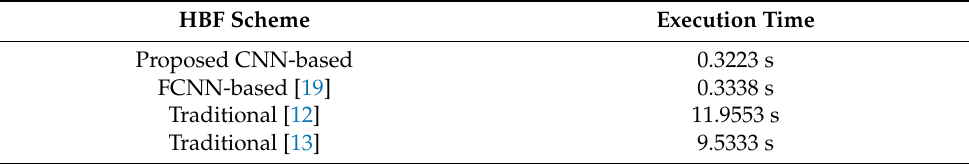
Table 3. Execution time